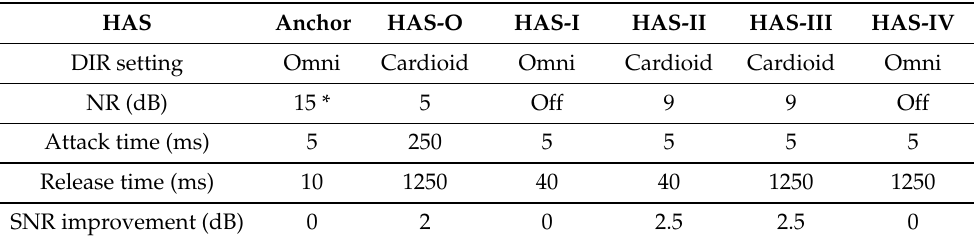
Table 2. Hearing-aid settings (HAS) evaluated in the multi-comparison experiment. The directionality (DIR) setting could be either omnidirectional (omni) or a fixed forward-facing cardioid setting. The noise reduction (NR) could provide an attenuation of 5, 9, or 15 dB, following the estimation of the speech signal. For the anchor stimulus, errors were deliberately introduced into the speech signal estimation to achieve a poor sound quality. The attack and release times of the amplitude compressor were similar to those used in previous studies. The HAS were characterized in terms of SNR improvement and spectral and temporal signal distortion in a complex noisy environment (Sanchez-Lopez et al., 2018). HAS Anchor HAS-O HAS-I HAS-II HAS-III HAS-IV DIR setting Omni Cardioid Omni Cardioid Cardioid Omni NR (dB) 15 * 5 Off 9 9 Off Attack time (ms) 5 250 5 5 5 5 Release time (ms) 10 1250 40 40 1250 1250 SNR improvement (dB) 0 2 0 2.5 2.5